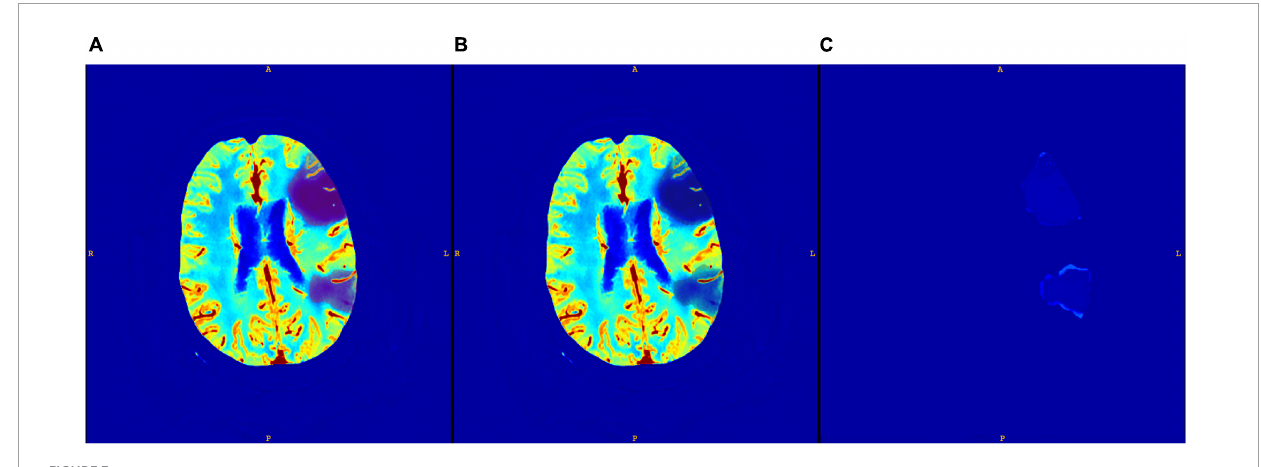
FIGURE3 Core segmented on CNN CBV map (A) ; core segmented on GT CBV map (B) ; and the difference between the two maps (C) .